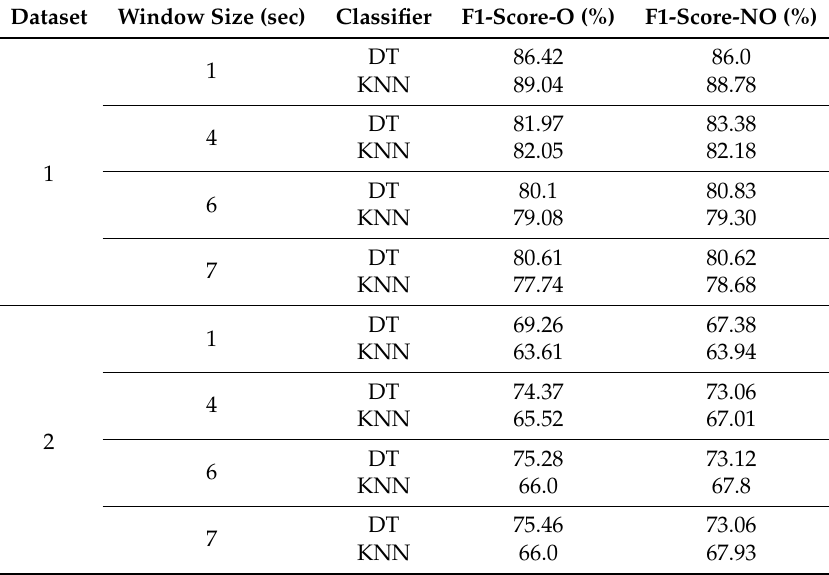
Figure 7. Experiment 2–Subject-independent CV–Dataset 1. ( a ) FS1; ( b ) FS2; ( c ) FS3. Table 3. F1 scores of DT and KNN for several window sizes in overlapping (O) and nonoverlapping (NO) windowing–Subject-independent